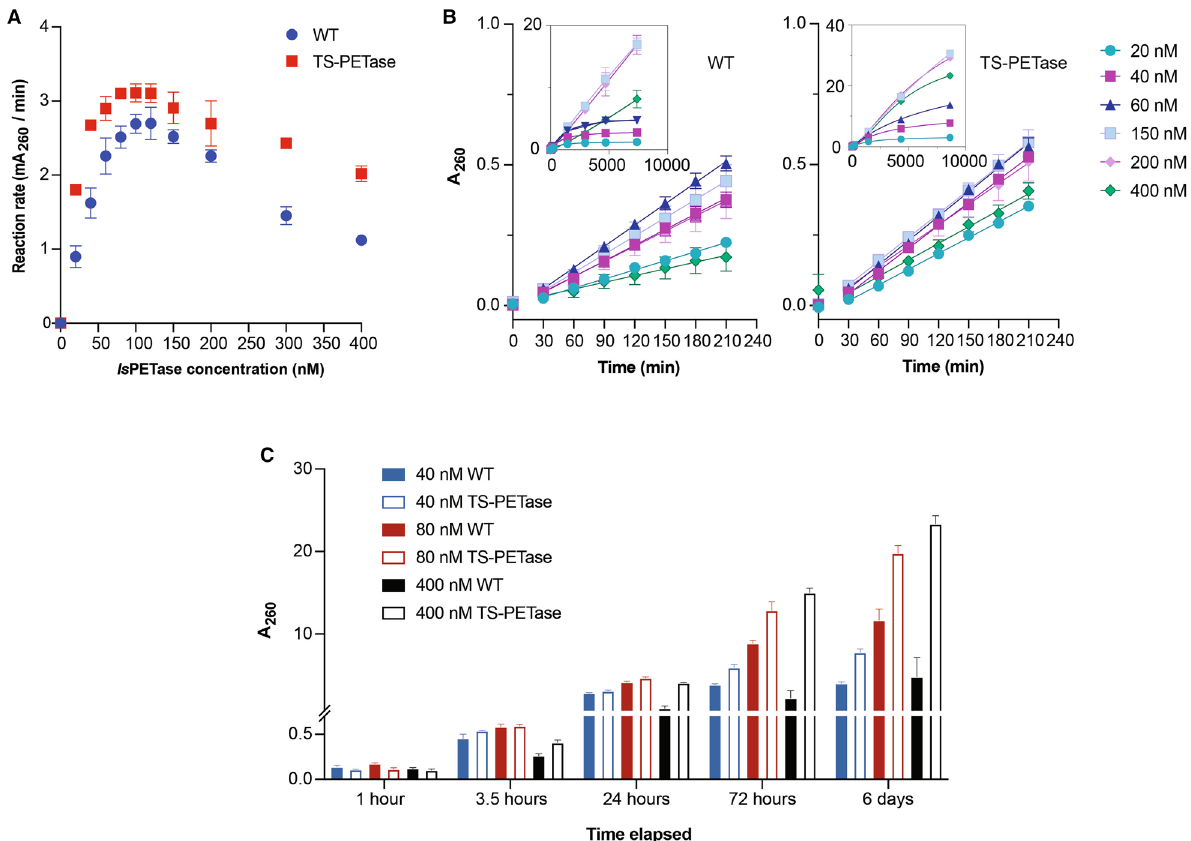
Figure 3. Wild-type vs. TS-PETase enzyme kinetics at 30ºC. ( A ) Plot of initial rates in terms of mA 260 per minute vs. enzyme concentration for wild-type and TS-PETase ( n ≥ 4 per concentration). All measurements were performed on a NanoDrop 1000 and values reported with a path length of 1 cm. ( B ) Initial rates determined using bulk absorbance at representative enzyme concentrations ( n ≥ 4 per concentration); insets display representative product accumulation profiles over extended time ( n = 3). ( C ) Comparison of product evolution profile by bulk absorbance of wild-type versus TS-PETase over six days ( n ≥ 3 per time point). Wild- type bars are solid, TS-PETase bars are bordered. Error bars for all panels represent SEM from two or more independent experiments performed on different effect was observed at higher concentrations of Is PETase, resulting in a maximum initial catalytic rate between 80 and 120 nM of enzyme for both Is PETase variants at 30 °C (Fig. 3A). This is consistent with the original Yoshida et al. report where they showed a decrease in overall product formation at higher enzyme concentra- tions (maximum production between 50–100 nM enzyme at 18 h) 11 . The S121E D186H R280A mutations were shown to improve product accumulation up to five-fold com- pared to the wild-type at 72 h and 30 °C 7 , and attempts to capture this behavior over time was made using the absorbance method. Interestingly, the five-fold improvement was not observed in initial catalytic rates, though the mutational background now contains an additional disulfide bond (Fig. 3A). Both TS-PETase and wild- type display linear initial rates, but the reaction eventually slows down (Fig. 3B). The timing of the slow-down is concentration and variant dependent; the general trend shows a delayed decrease in product formation rate with increasing enzyme concentration (Fig. 3B). TS-PETase is revealed to have a different velocity vs. enzyme concentration profile compared to the wild-type for both initial rates and long-term product accumulation, sug- gesting altered enzyme behavior during degradation of PET. TS-PETase exhibits 1.6- to 2-fold higher initial rates at low (20 and 40 nM) and high enzyme concentrations (300 and 400 nM), while the maximum initial velocity achieved by TS-PETase was 20% higher than wild-type based on bulk absorbance (Fig. 3A). Differences are seen in product evolution profiles between the wild-type and TS-PETase over the course of multiple days, which deviate from initial rate comparisons (Fig. 3C and Supplementary Fig. 8 for day 6 HPLC results). Estimated differences in A 260 reach 6.8-fold after 72 h and 4.9-fold after 6 days at 400 nM (TS-PETase vs. wild-type). The fold-differences in product accumulation between TS-PETase and wild-type are also higher at 72 h compared to 24 h. These results are consistent with the maximum 5.2-fold difference observed at 72 h reported by Son et al . 7 . Conversely, the fold-differences in products observed in the present study between TS- PETase and wild-type at 40 nM and 80 nM of enzyme ranged between 0.6- to 1.9-fold throughout the time course. Together, these results suggest that the large fold-differences observed at late time points between TS-PETase and wild-type are likely due to improved stability instead of improved catalytic rates.